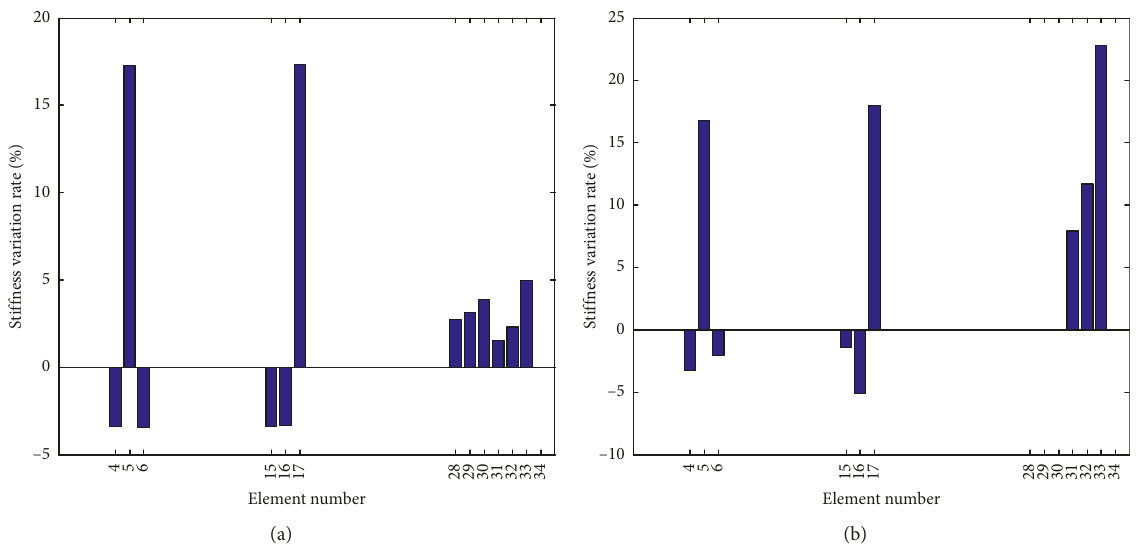
Figure 14: Dynamic substructuring approach: (a) noise-free measurement data; (b) measurement data contaminated by 5%